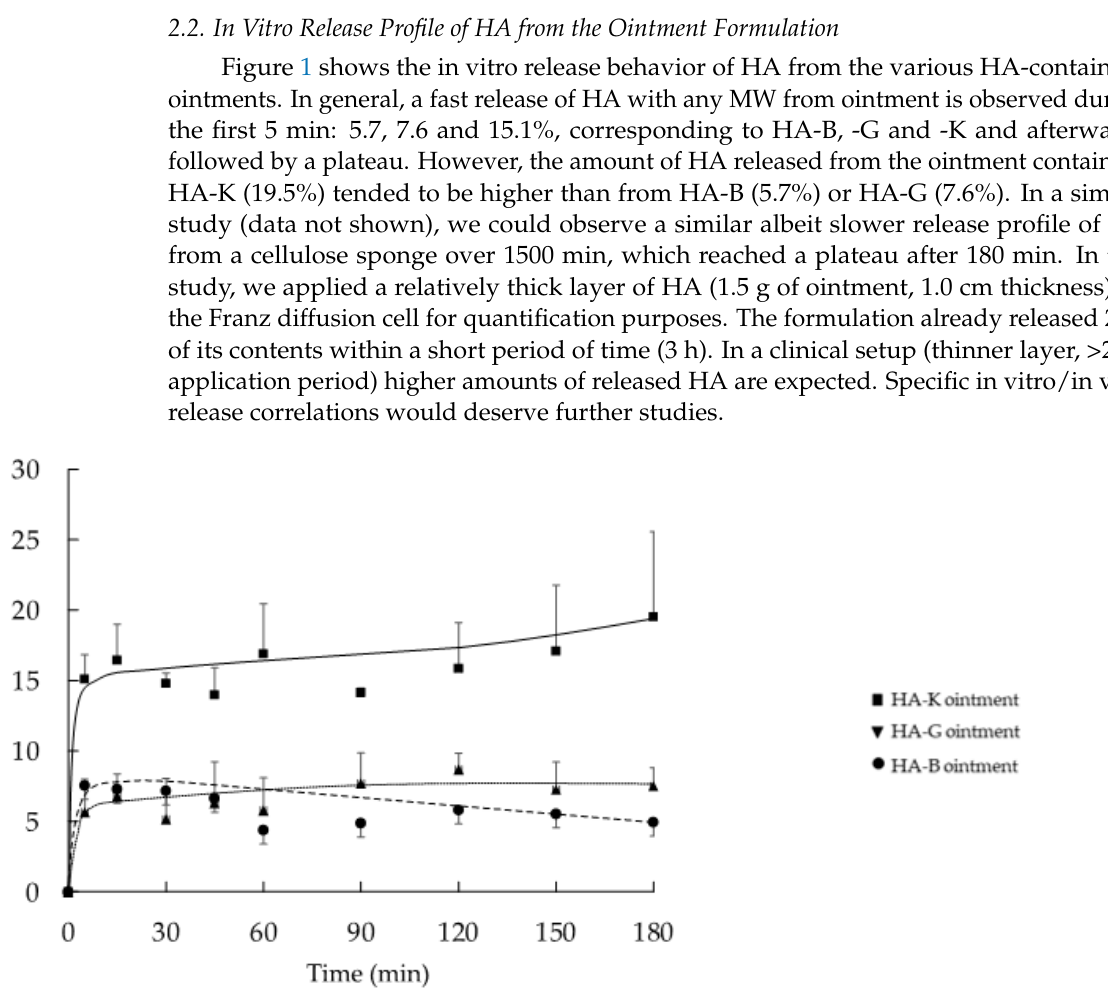
Figure 1. In vitro cumulated release fraction of HA from the various ointment formula HA-B (8 kDa), -G (987 kDa) and -K (2290 kDa) ( n = 3, mean ±